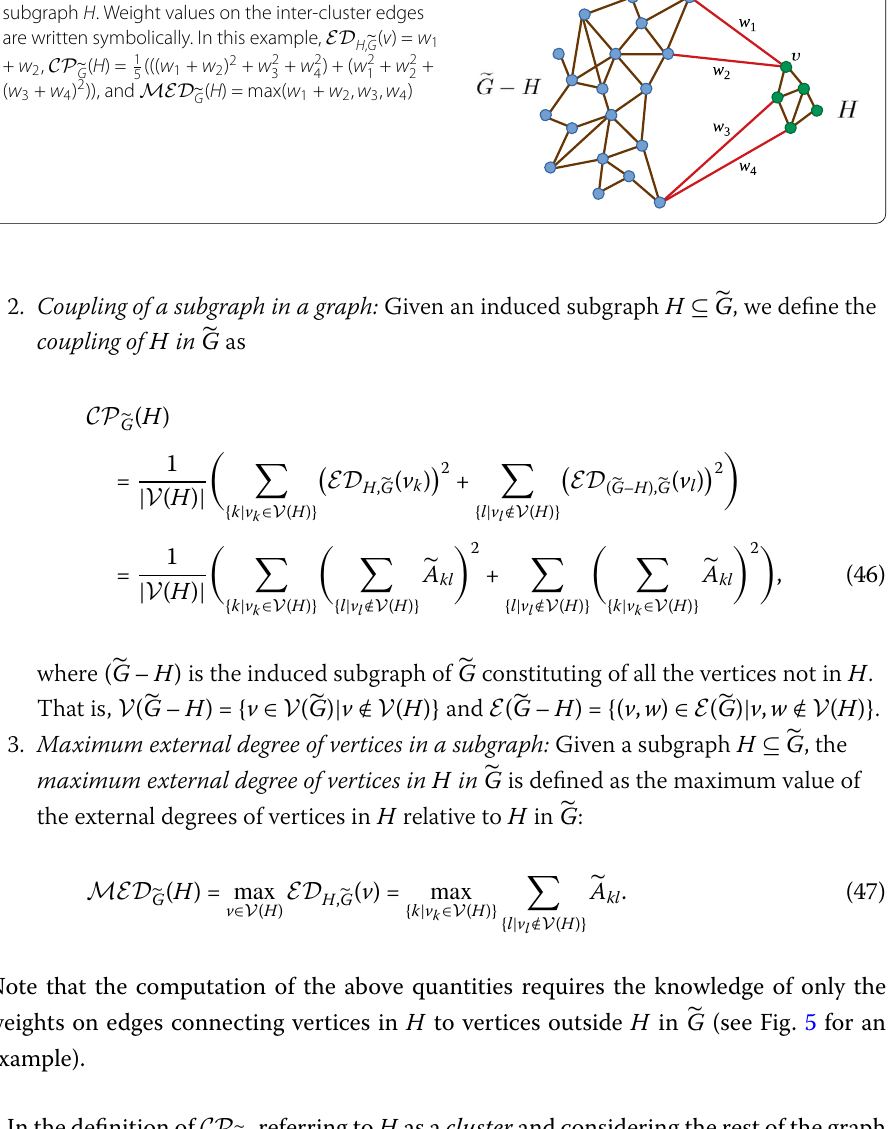
Figure 5 An example graph (cid:2) G and induced subgraph H . Weight values on the inter-cluster edges are written symbolically. In this example, ED H , (cid:2) G ( v ) = w 1 + w 2 , CP (cid:2) G ( H ) = 1 ((( w 1 + w 2 ) 2 + w 2 3 + w 2 4 ) + ( w 2 1 + w 2 2 + 5 ( w 3 + w 4 ) 2 )), and MED (cid:2) G ( H ) = max( w 1 + w 2 , w 3 , w 4